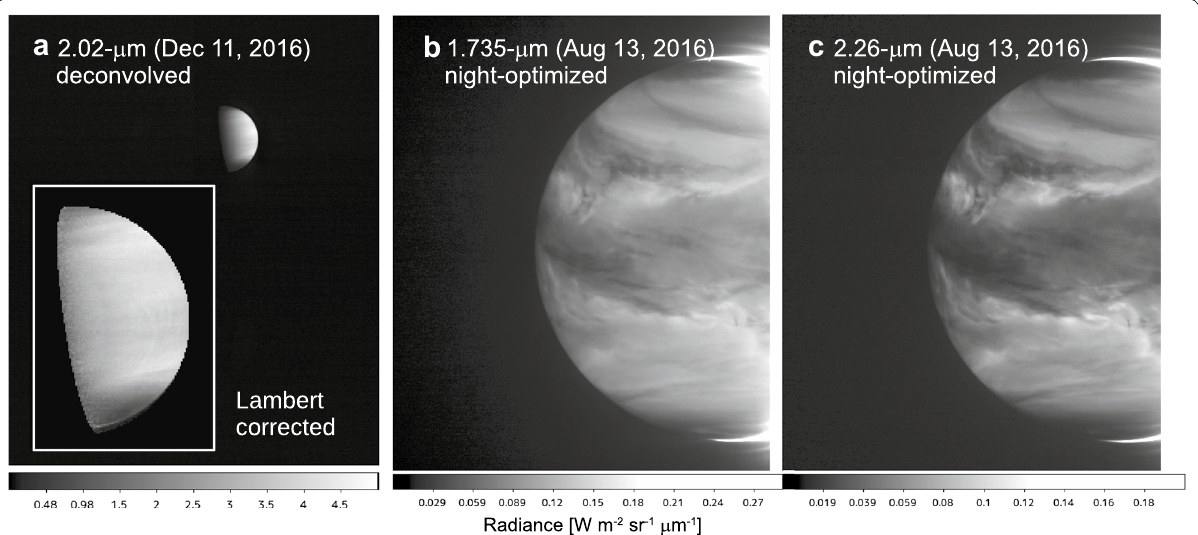
Fig. 3 Example of IR2 images obtained during Venus orbit. a First‑light Venus image acquired with IR2 at 2.02 μm (December 11, 2015, decon‑ volved with the PSF described in the text). The inset is corrected for limb darkening by assuming Lambertian intensity distribution. The large‑scale bow‑shaped feature is hinted at although not as prominent as in LIR images (Fukuhara et al. 2017); b , c example images of the night‑side of Venus at 1.735 and 2.26 μm (August 13, 2016, acquired with “night‑optimized” observation). The 2.32‑μm image is omitted as it appears almost identical to the 2.26‑μm image